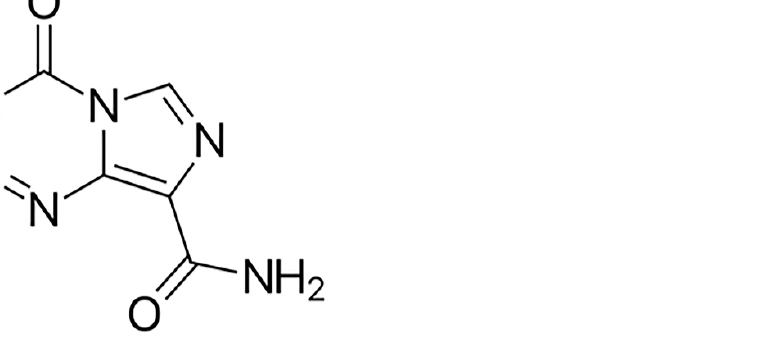
Figure 1. Chemical structure of Temozolomide, acquired from PubChem database.